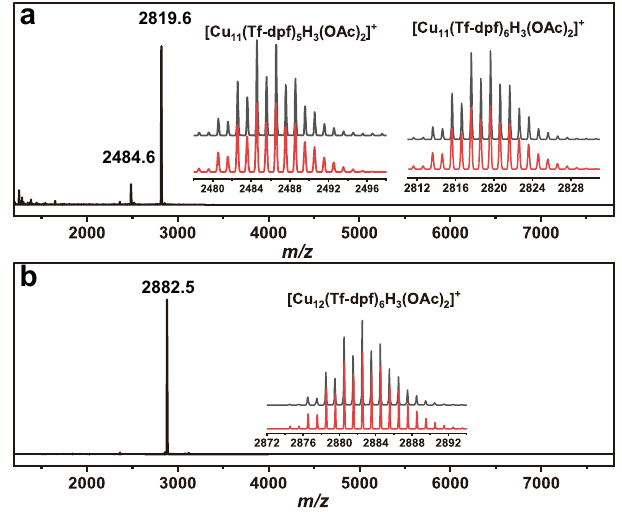
Fig. 2 ESI-MS of Cu 11 and Cu 12 in MeOH. Mass spectra of Cu 11 ( a ) and Cu 12 ( b ), inset: the measured (black trace) and simulated (red trace) isotopic distribution patterns of the corresponding the molecular ion